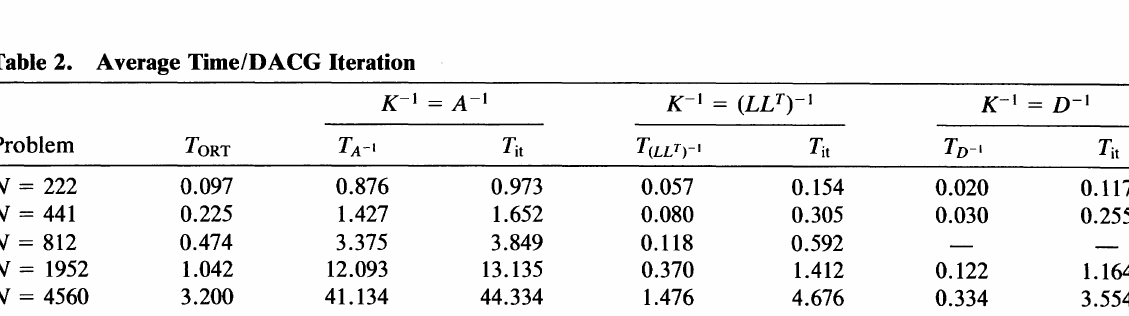
Table 2. Average Time/DACG